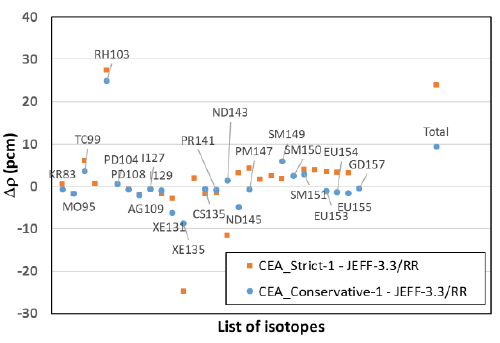
Fig. 25. (Preliminary results) Variation of reactivity for the “Strict 1” and “Conservative 1” FY evaluations in reference of the JEFF-3.3 for a burn up of 50